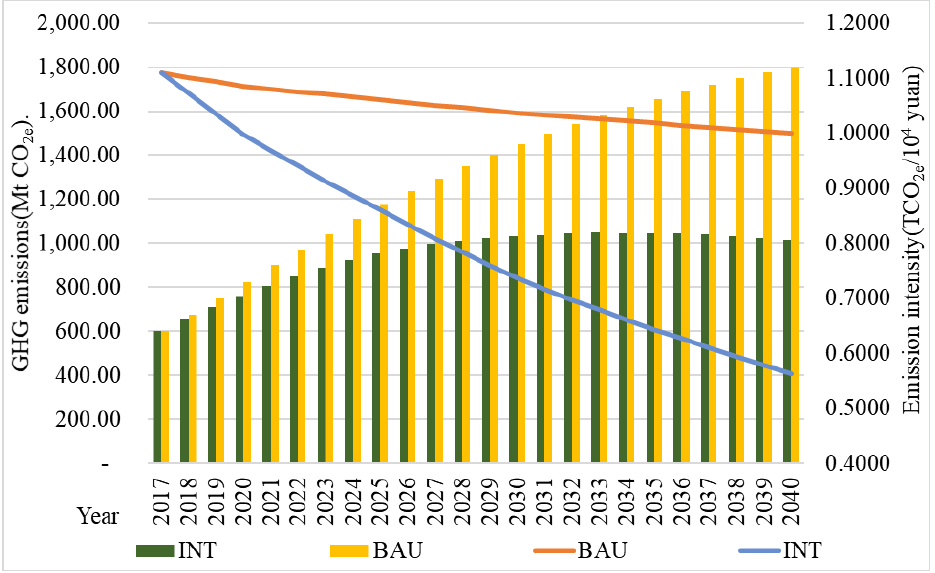
Figure 5. Prediction of greenhouse gas (GHG) emissions and emission intensity under the two scenarios.